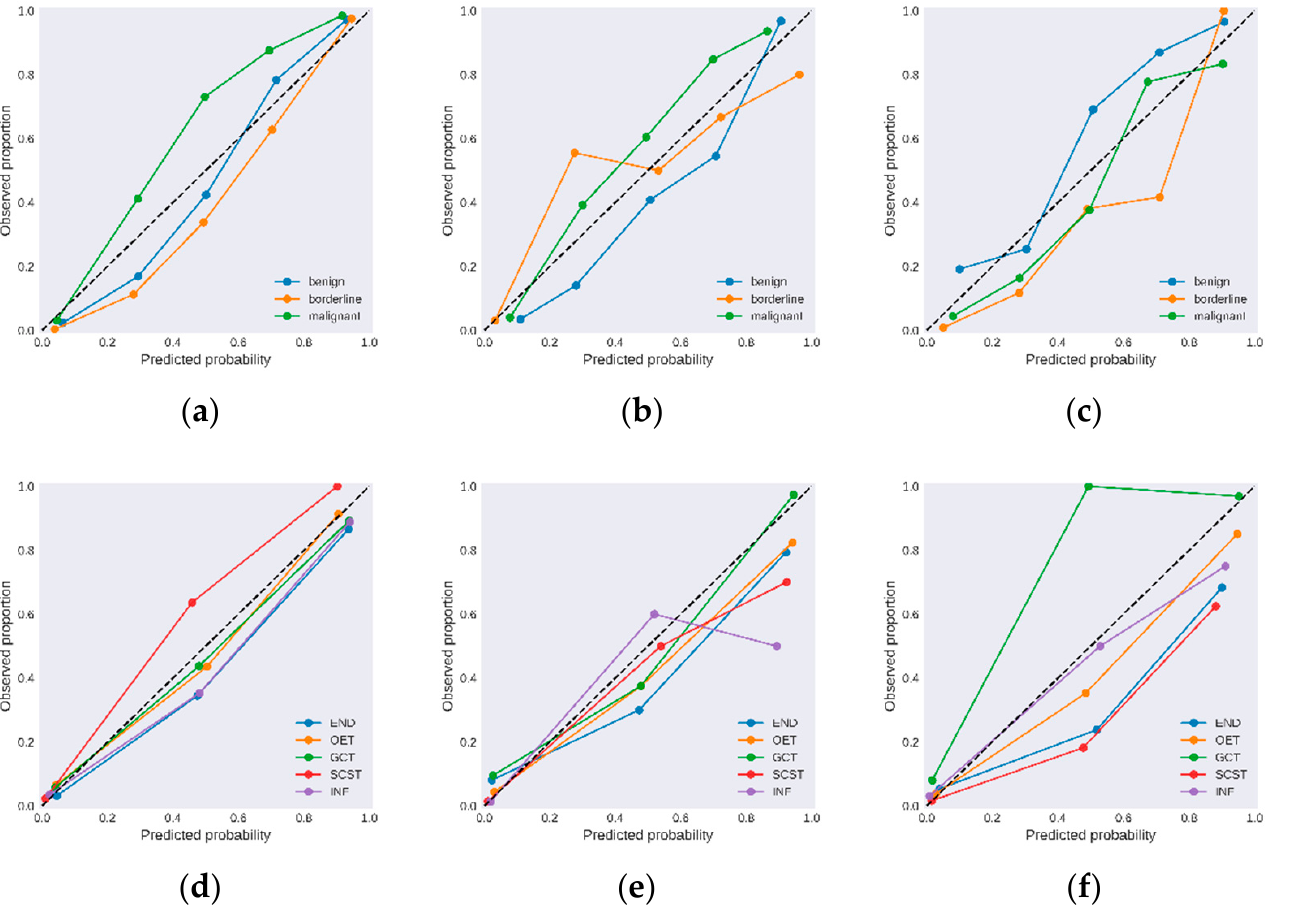
Figure 6. Example ultrasound images of different types of adnexal masses and different pathological subtypes of benign tumors. 3.4. Comparison with Sonographers The diagnostic performance parameters of three reviewers with different experience were evaluated using the external test datasets (Table 4).